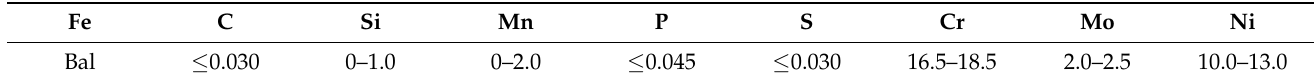
Table 1. Chemical composition of CL20ES steel powder (material data Concept Laser